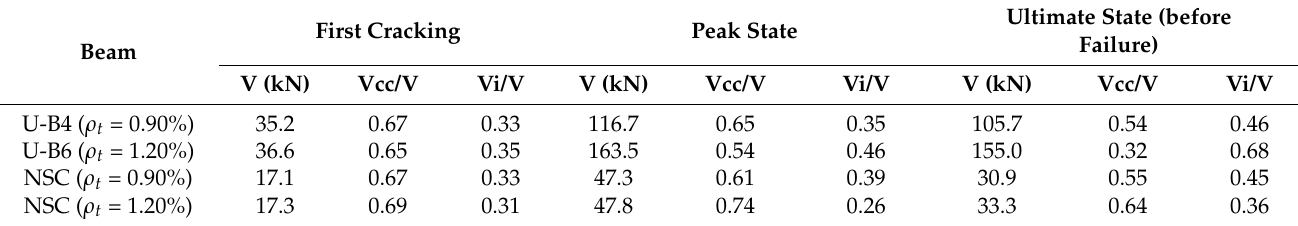
Table 2. Contribution of compression block and interface resistance to shear